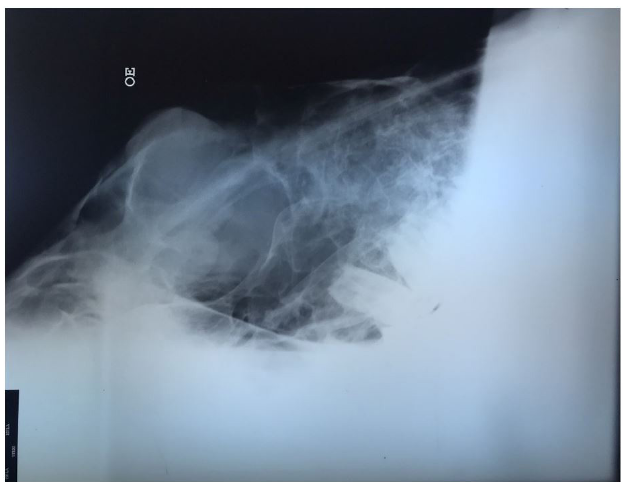
Figure 2. Radiographic examination in left lateral oblique projection of the skull of a six-year-old donkey. An increase in volume and of radiopacity with variable density in the nasal cavity, and in the maxillary sinuses, frontal region, and left orbit can be